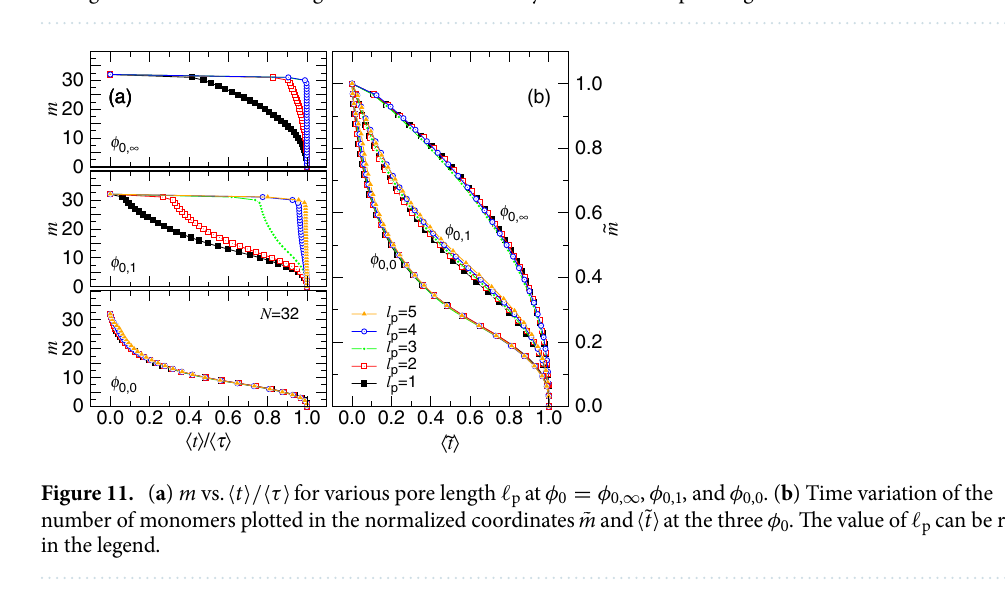
1 )/ t m − 1 /ζ 1 vs. m by setting ζ 1 − � � ˜